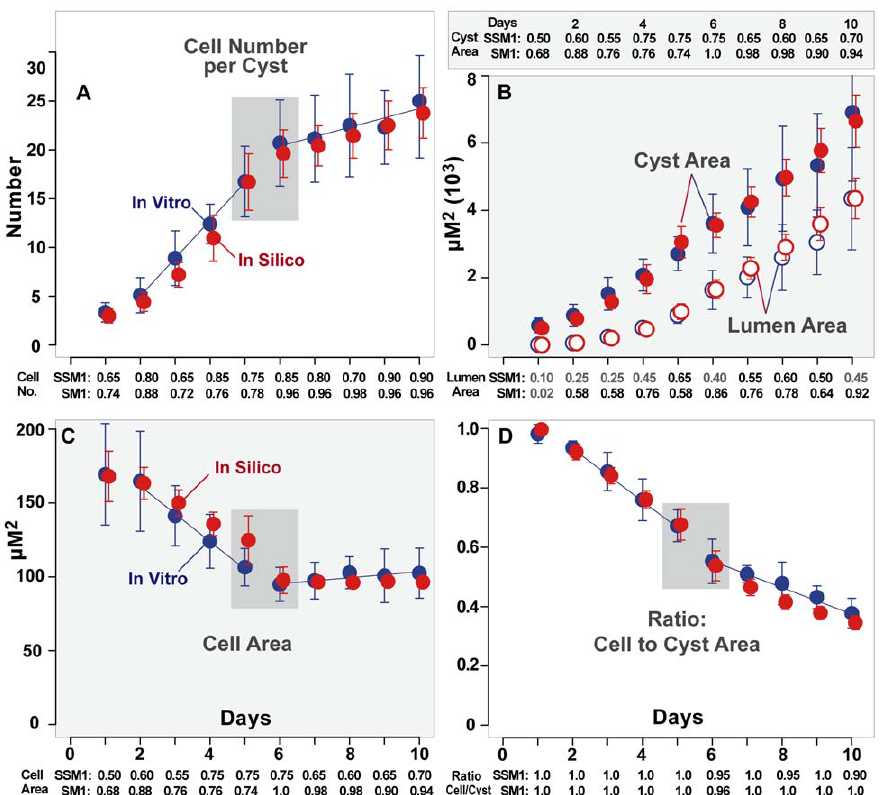
Figure 2. Quantitative measures of in vitro and in silico cystogenesis. Mean values and standard deviations for (A) cell number per cyst, (B) cyst and lumen area, (C) mean individual cell area and (D) ratio: cellular to cyst area. Blue: in vitro data taken each day for ten days from 20 cysts. Red: data taken from 50 CYSTS over ten DAYS using the parameter values in Table 2. Gray boxes: noted changes in behavior. Blue lines: slope of in vitro growth illustrating changes in rate. SSM1: Self -Similarity Measure of in vitro growth; SSM1 indicates the percentage of in vitro values each day that fell within 6 25% of the mean in vitro value for that day. SM1: Similarity Measure for ISMA growth. SM1 indicates the percentage of ISMA values each day that fell within 6 25% of the mean in vitro value for that day. The target was that SM1 . 0.5 for nine of ten DAYS . When the target was met, we posited that ISMA measures were experimentally indistinguishable from in vitro measures. Gray SM values did not achieve targeted values. doi:10.1371/journal.pcbi.1002030.g002 (Figure 2D) indicated that the portion of cyst occupied by cells decreased as cysts expanded (and thus the portion occupied by lumen increased). The ratio decreased quite steeply between days